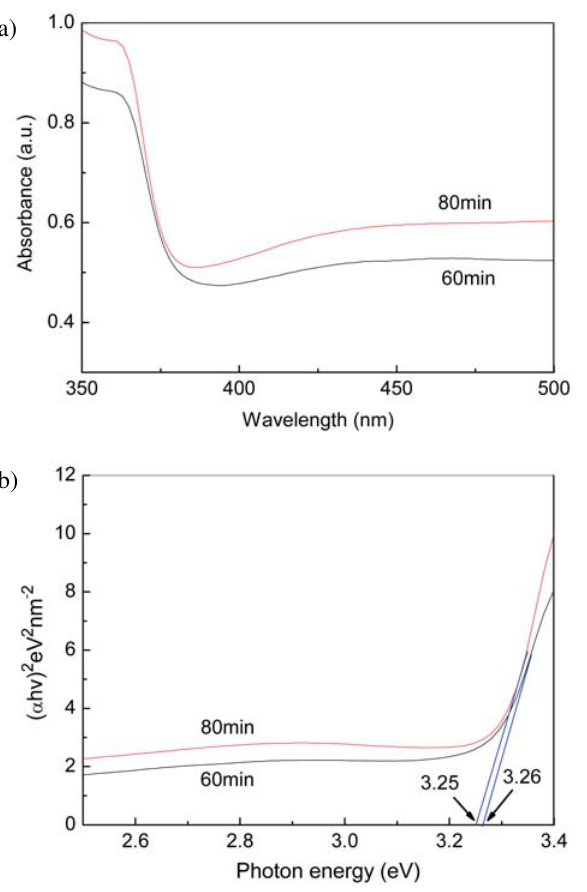
Fig. 7. UV–visible spectra of ZnO microrods grown with various growth time (a) and the corresponding band gap calculation (b).